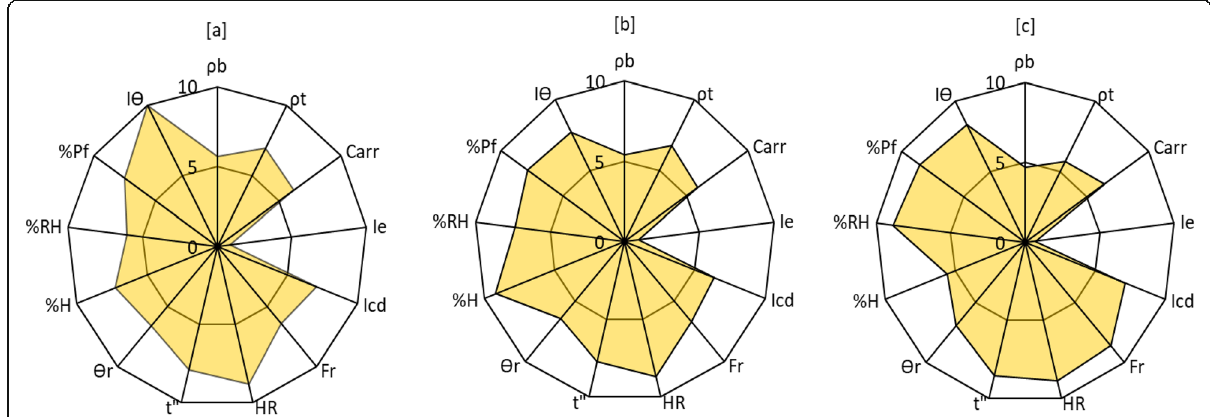
Fig. 3 SeDeM diagrams of engineered Starch-MCC composite ( a ), StarLac® ( b ), and MicroceLac®100 ( c )